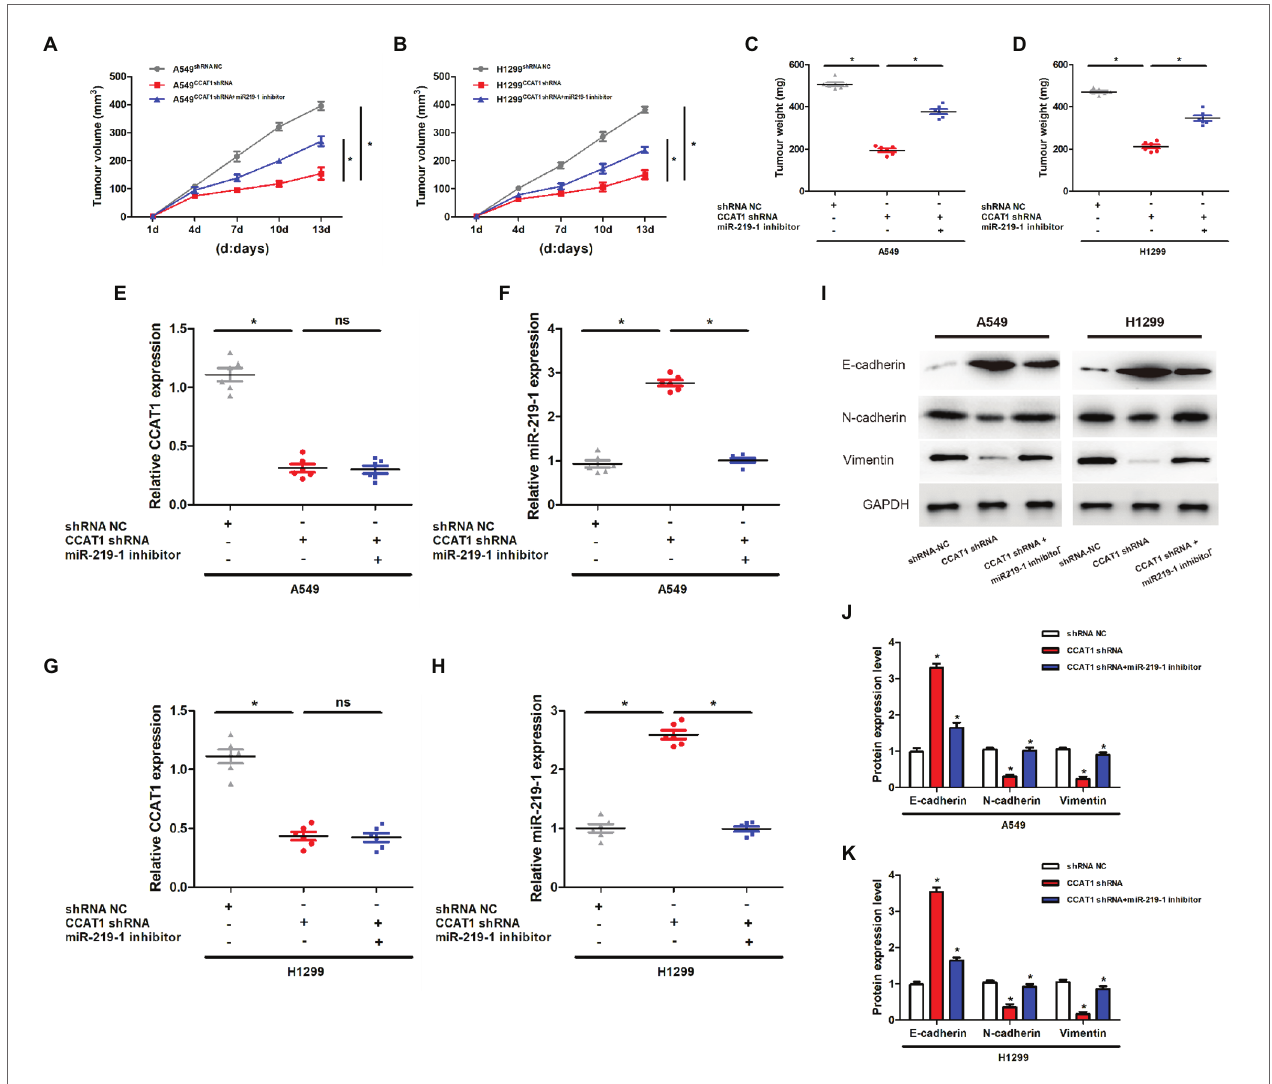
FIGURE 5 | CCAT1 knockdown inhibits the growth of tumor xenografts in nude mice via miR-219-1. (A,B) Tumor volumes of the xenografts in nude mice. (C,D) Tumor weights of the xenografts in nude mice. (E,G) The expression of CCAT1 in mice with shRNA NC, CCAT1 shRNA, and CCAT1 shRNA+ by the miR-219-1 inhibitor. (F,H) The expression of miR-219-1 in mice with shRNA NC, CCAT1 shRNA, and CCAT1 shRNA+ by the miR-219-1 inhibitor. (I–K) Expression of E-cadherin, N-cadherin, and vimentin. * p < 0.05; ns: not